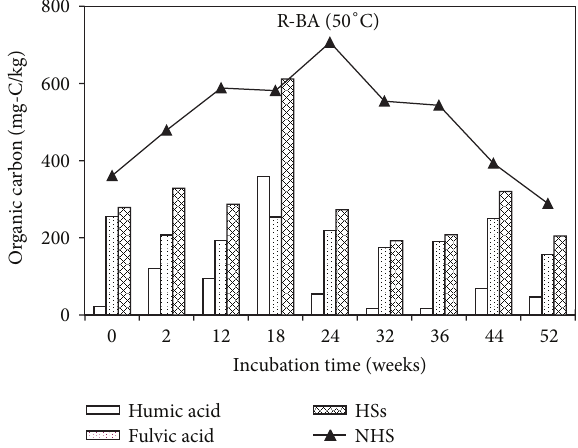
Figure 4: Humic substances and nonhumic substances contents as a function of incubation time in R-BA incubated under 50 ∘